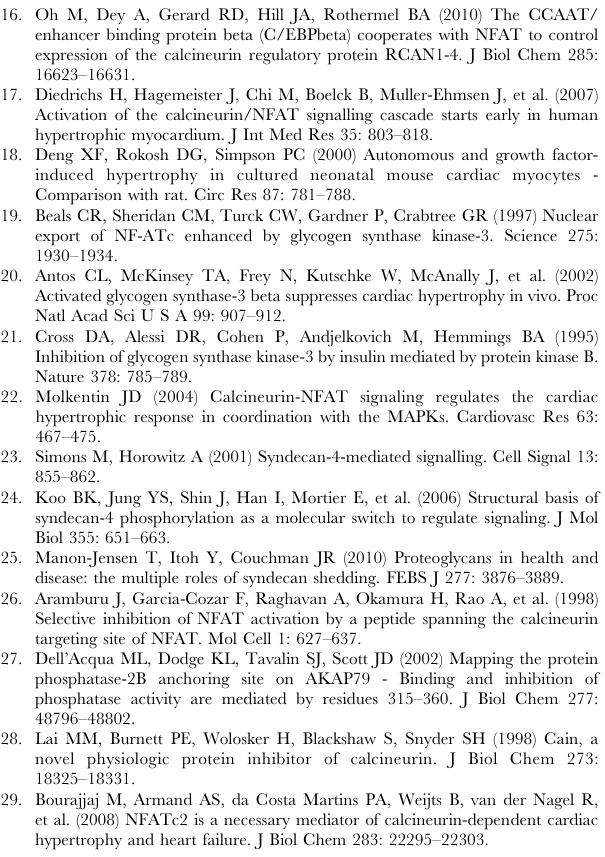
Table S1 Animal characteristics, heart rates, left ventricular pressures and echocardiographic measurements. Table S2 Myocardial structure and neurohormonal